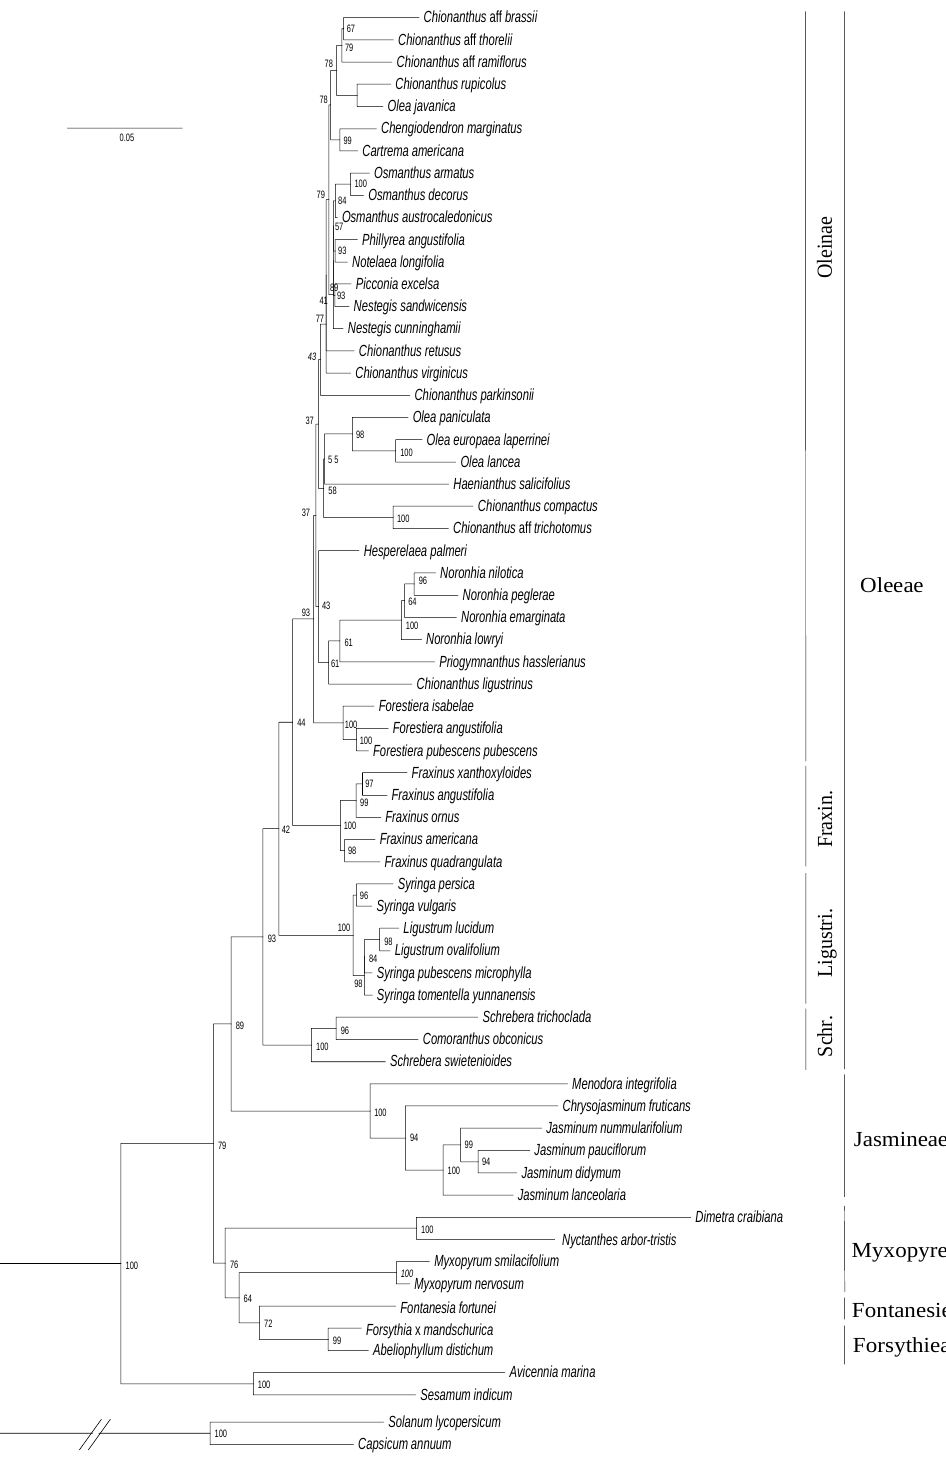
Figure 3. Maximum likelihood phylogenetic tree of Oleaceae based on the complete RY-coded nrDNA cluster alignment. The tree was rooted on the split with Solanaceae. The scale is in substitution per